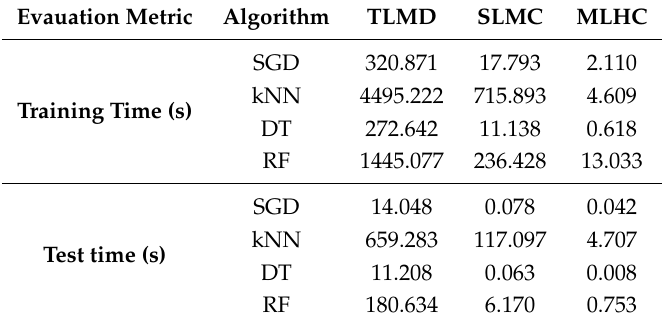
Table 7. Simulation results for elapsed